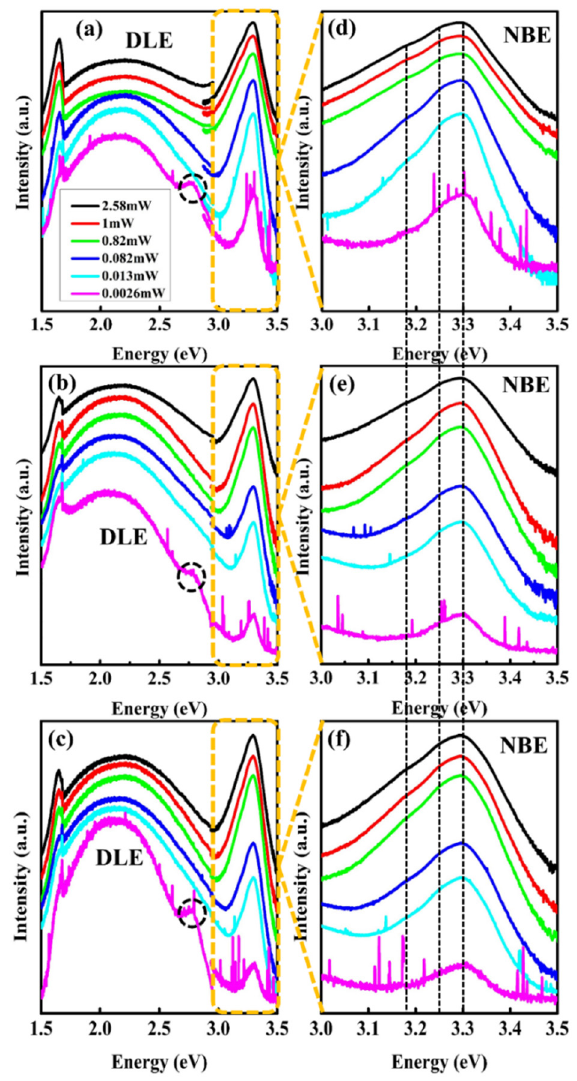
Figure 10. Excitation power-dependent photoluminescence spectra of ( a ) <0001> ( b ) <1120> and ( c ) <1010> orientation of ZnO single crystal. The dashed circle is an “unknown emission band” which is not related to the ZnO but could be scattering from system itself. Figure ( d – f ) represents the zoom-in on near band edge emission region of <0001>, <1120>, and <1010> orientation, respectively. Here NBE and DLE represent the near-band-edge and deep level emission, respectively.